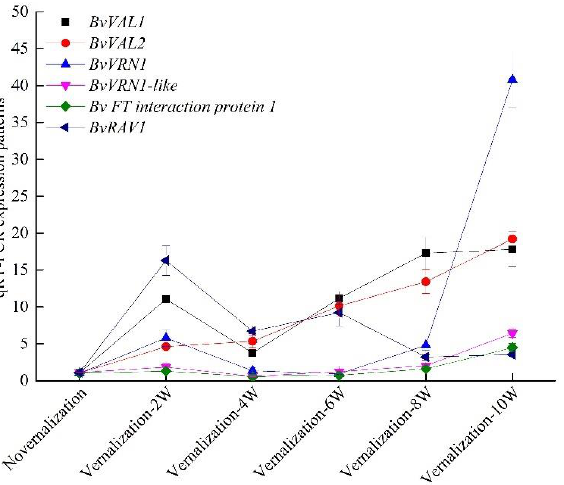
Figure 6. The expression patterns of BvVRN1-like (Bv5_119850_xzuy.t1), BvVRN1 (Bv6_136060_dknq.t1), BvRAV1 (Bv6_140480_qrgc.t1), BvVAL1 (Bv7_179010_ycqe.t1), BvVAL2 (Bv7_156080_dced.t1) and BvFT-interacting protein 1 (Bv4_072340_puin.t1) (Table S1). 3.4. Verification of Vernalization-Related mRNAs and lncRNAs by qRT-PCR